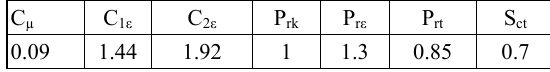
Table 1. Empirical constants in the standard k- ε